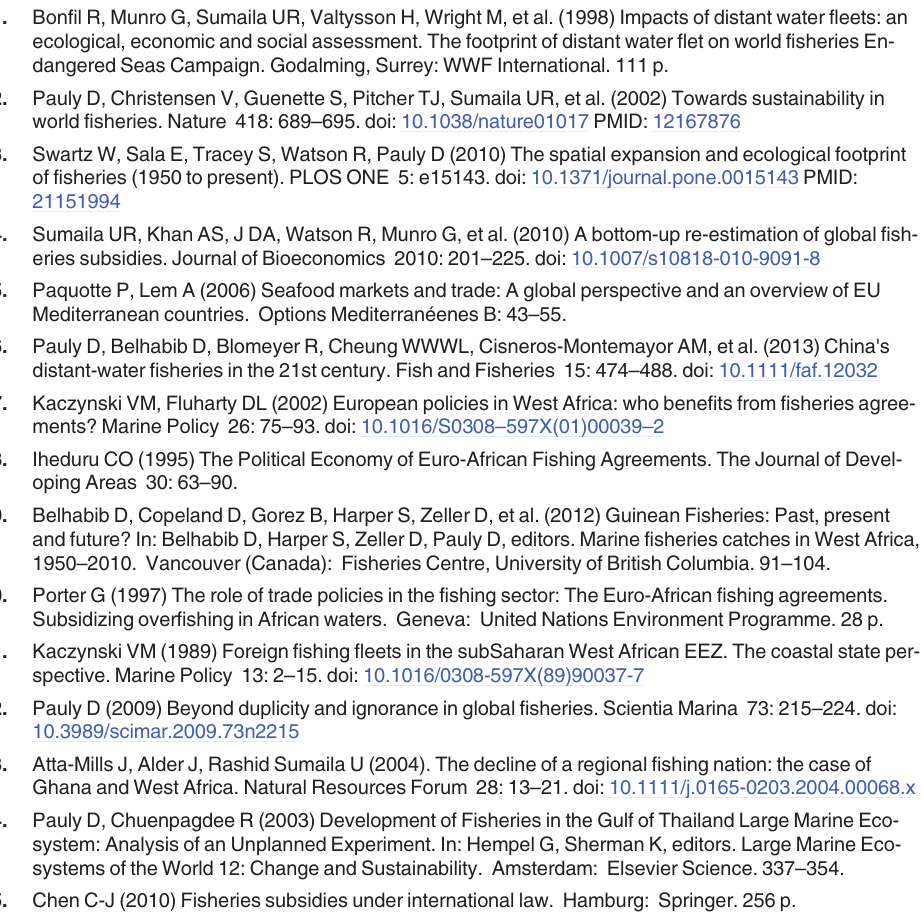
S1 Table. Materials for estimating the annual value of Chinese legal access to West African fishing grounds, 2000 –